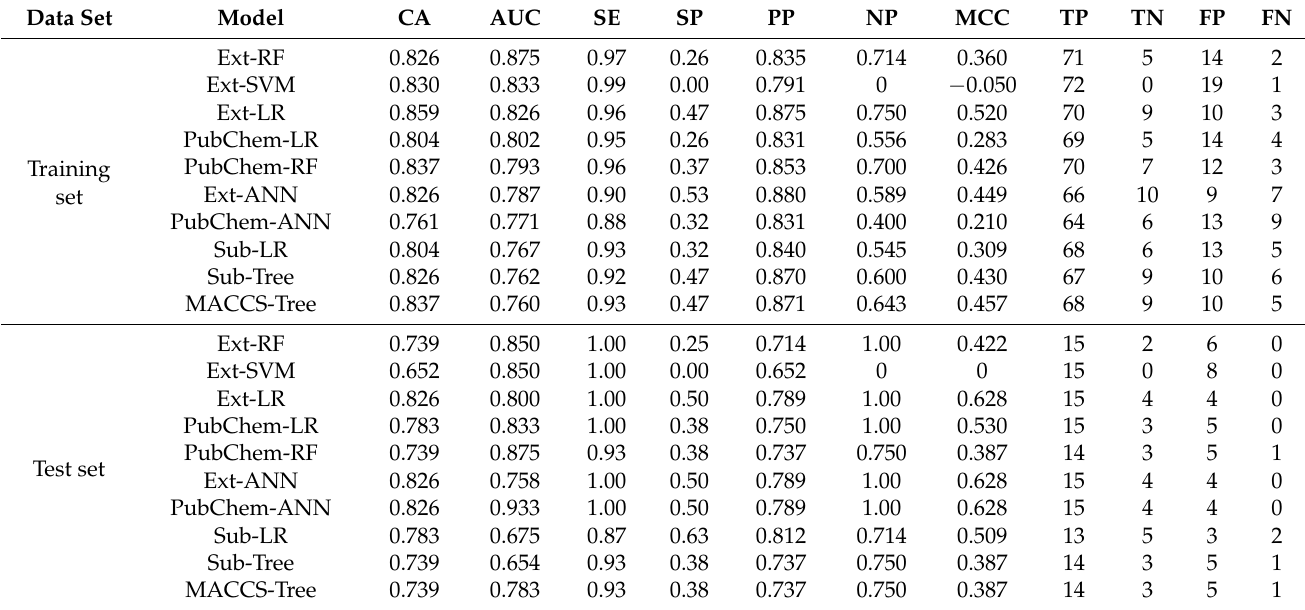
Table 1. Performance of top 10 classification models for the training set and test set.